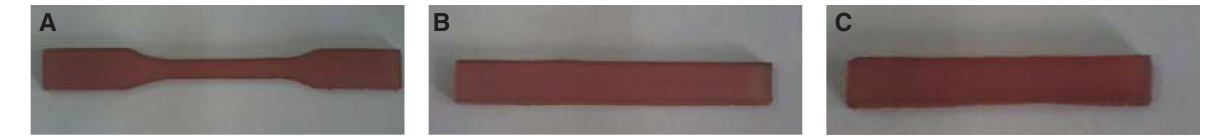
Figure 1 Pictures of specimen shapes: (A) tensile test specimen; (B) bending test specimen; and (C) impact test